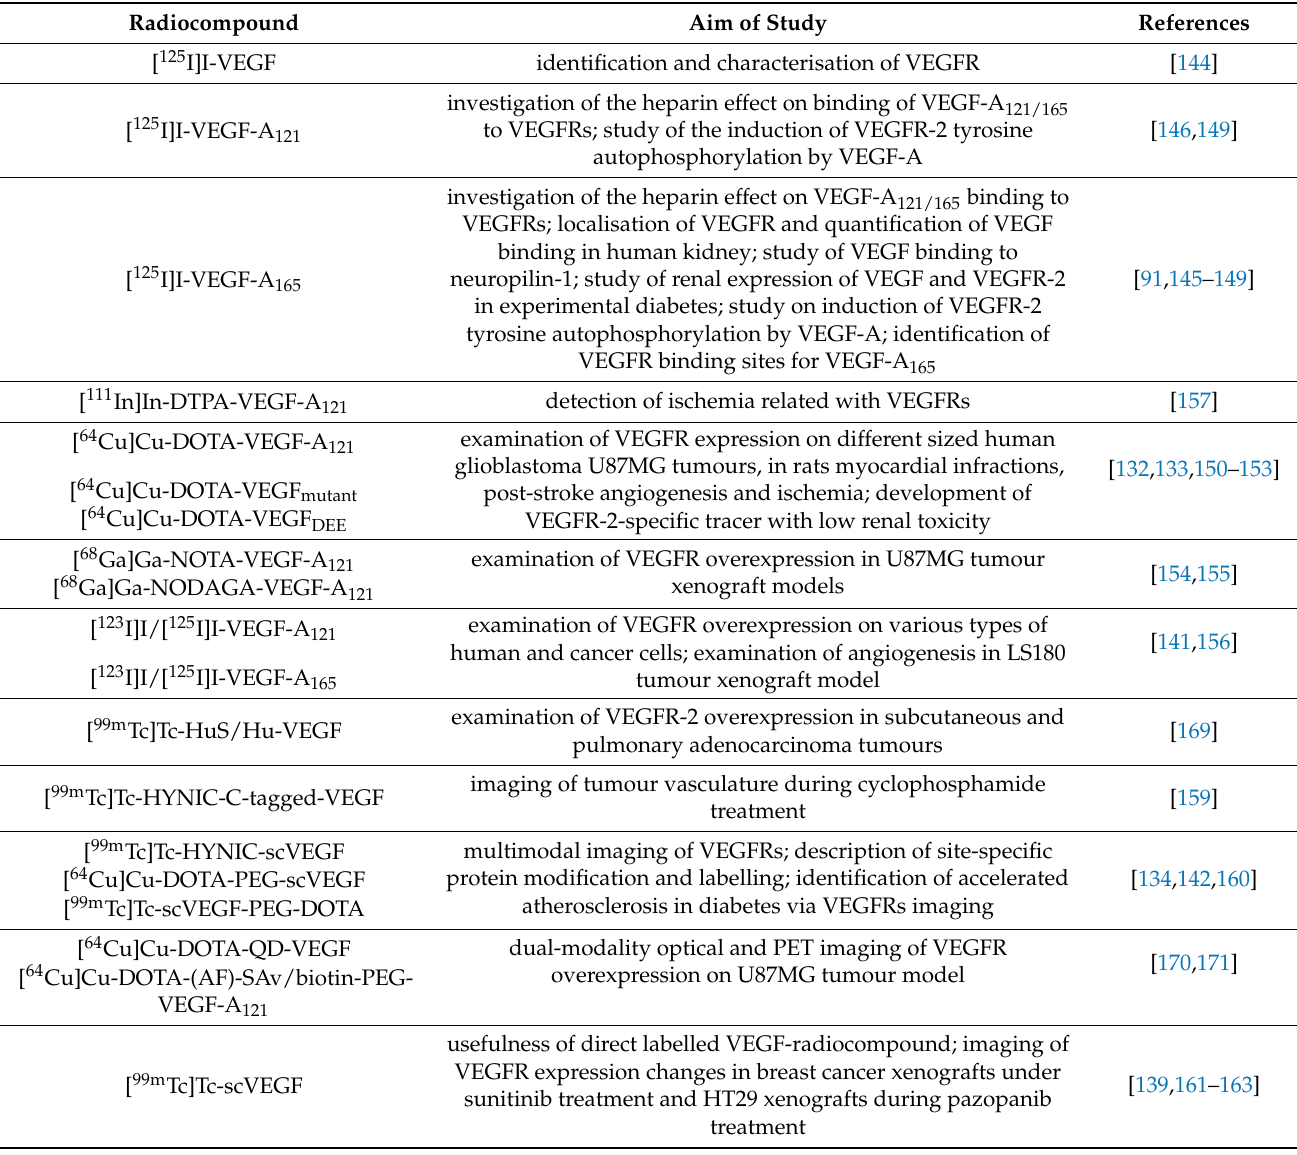
Table 1. Radiolabelled VEGF ligands and their